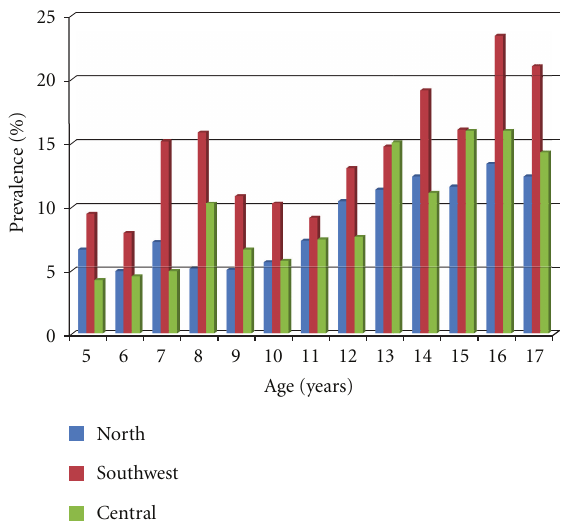
Figure 1: Regional variation in prevalence of short stature accord- ing to